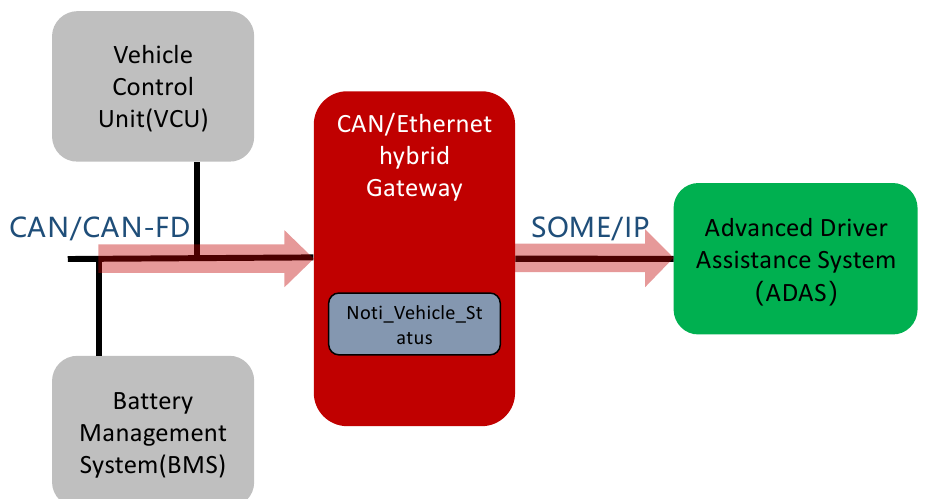
Figure 6. Application case of the CAN/CANFD to SOME/IP gateway.